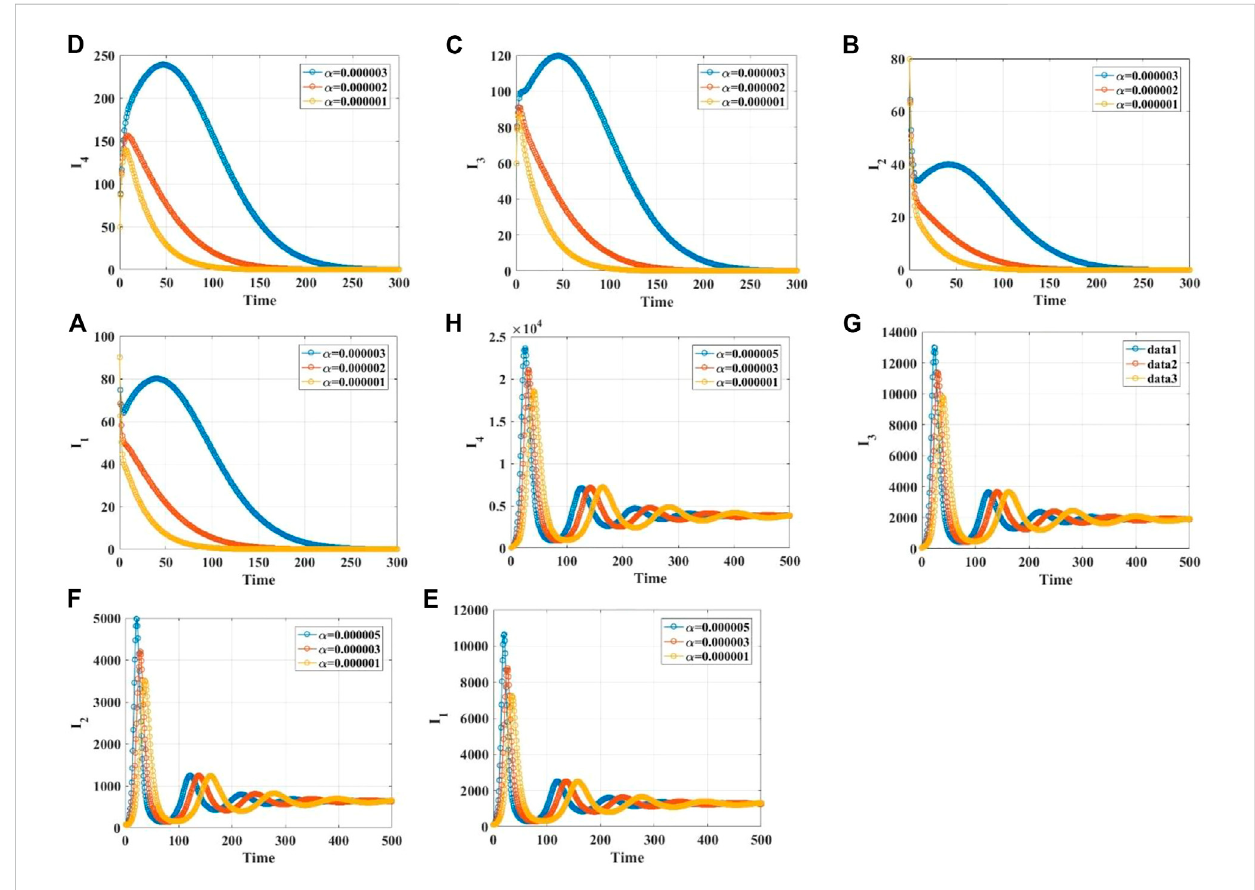
The time series diagrams for n (cid:1)